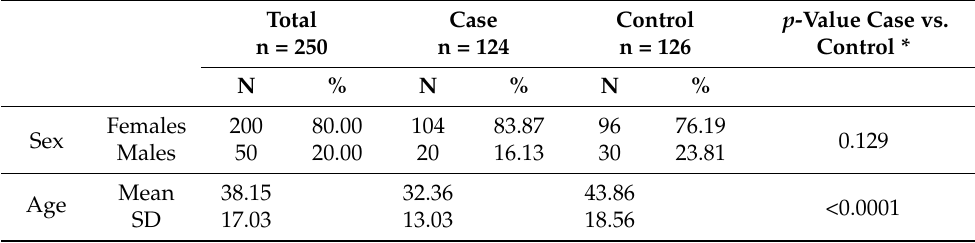
Table 1. Patient characteristics by the